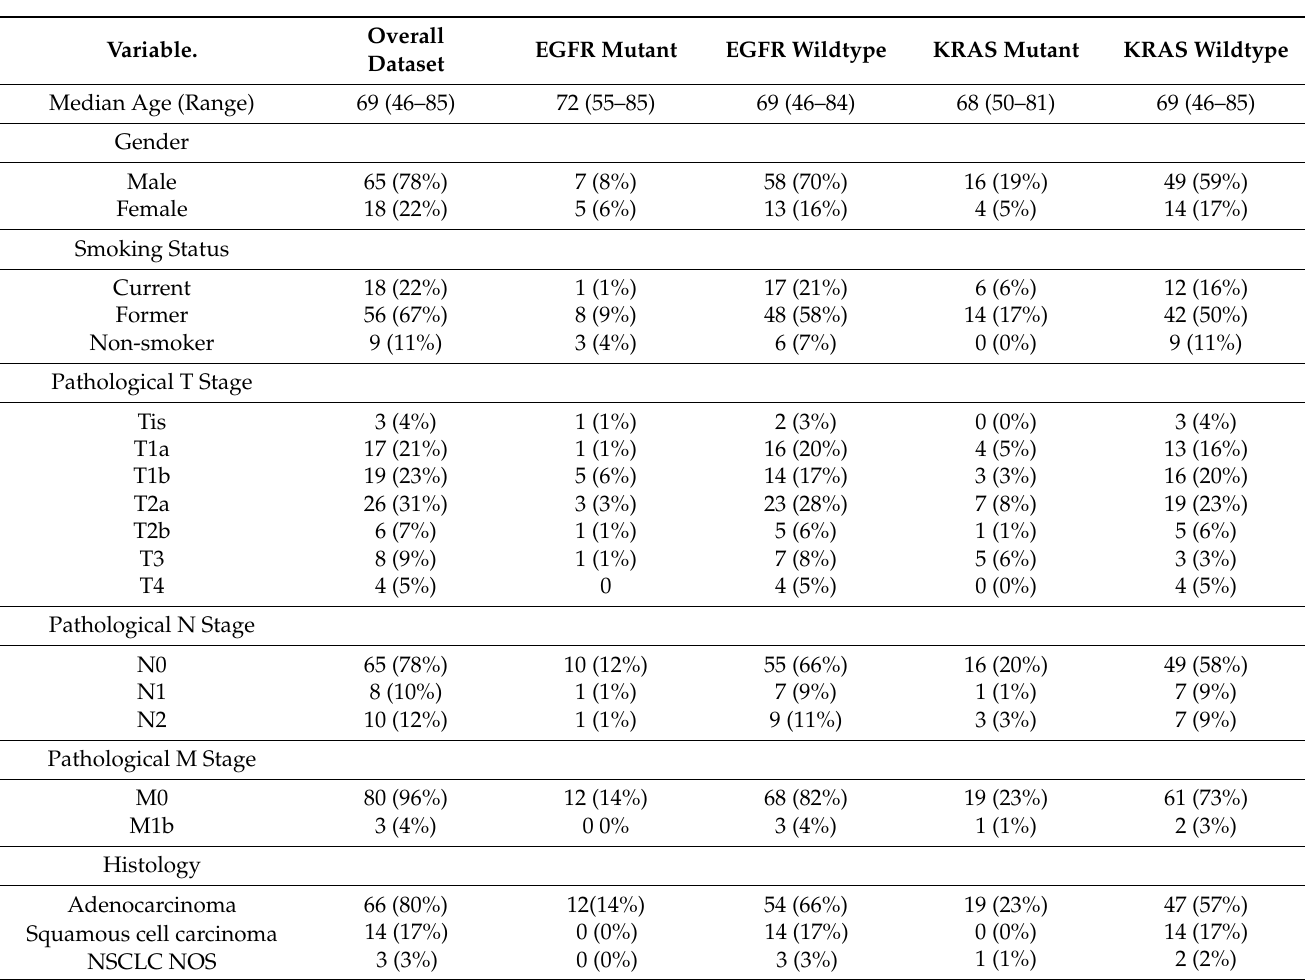
Table 2. Clinical features data